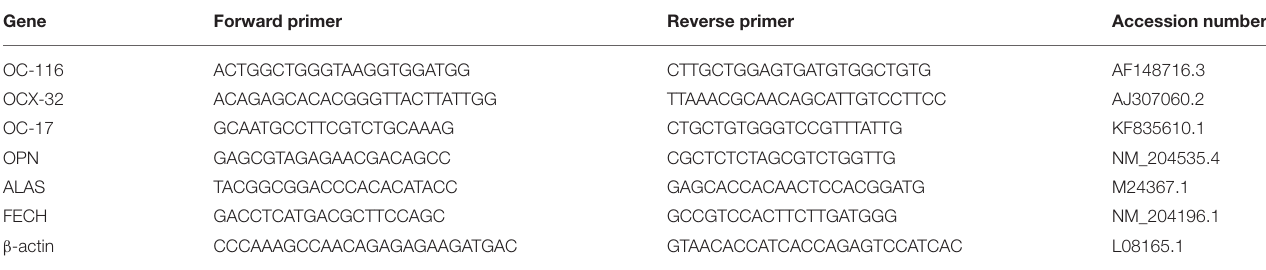
TABLE 2 | Primer used for Real-time PCR of eggshell gland.